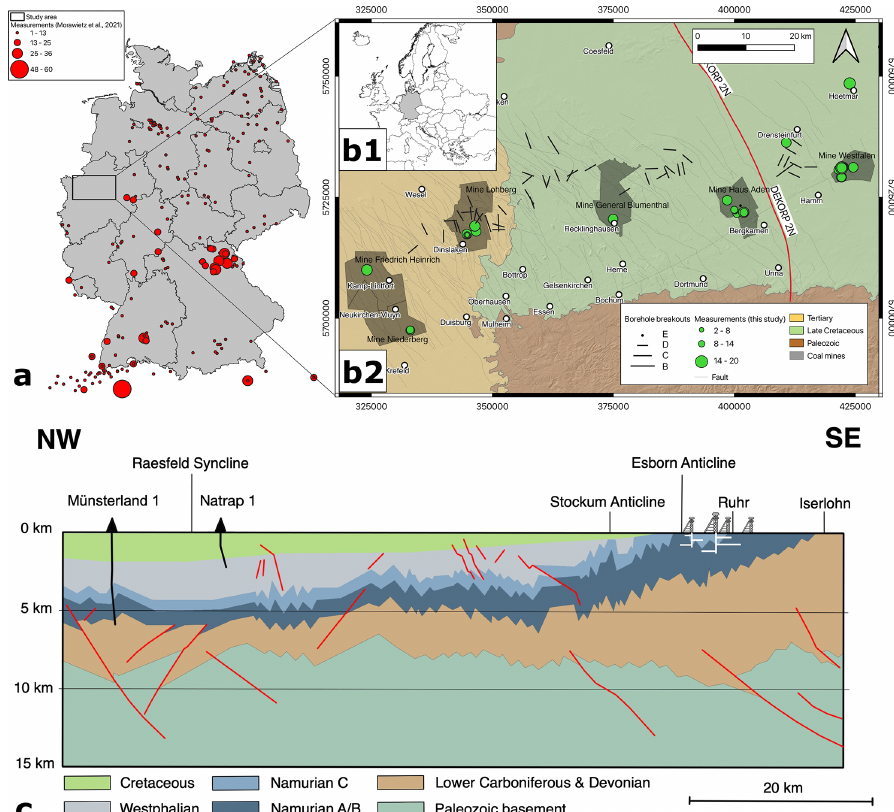
Figure 1. (a) A map of Germany with administrative regions and available stress magnitudes from Morawietz et al. (2020); (b1) the location of Germany (marked in grey) within Europe; (b2) a map of the greater Ruhr region with major fault zones (modified after GD NRW, 2017, 2019) and locations of stress magnitude data records described in this study with black shaded areas representing coal mines active in 1980s (black thick lines show the orientation of the maximum horizontal stress, S Hmax , available in the World Stress Map database (Heidbach et al., 2018), where line length is proportional to the data quality); DEKORP 2N seismic line (DEKORP, 1990; Stiller et al., 2021) marked in red; (c) a simplified geological cross-section of the northern part of the DEKORP 2N seismic line (DEKORP, 1990) with fault zones marked in red (modified after Drozdzewski,